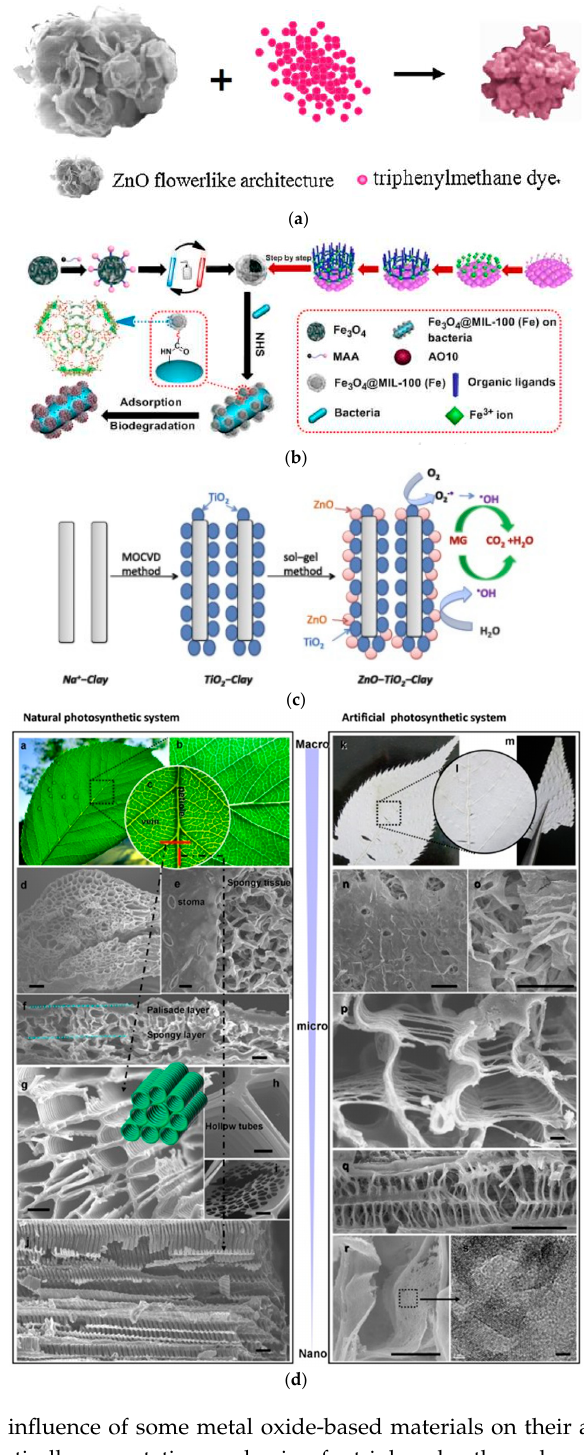
Figure 1. Structural influence of some metal oxide-based materials on their associated properties. ( a ) Absorption schematically presentation mechanism for triphenylmethane dyes on the ZnO flowerlike architectures. ( b ) AO 10 biodegradation and adsorption using Fe 3 O 4 MIL-100 (Fe) Core–Shell Bionanocomposites. ( c ) Design and application of ZnO–TiO 2 / clay. ( d ) Comparison of NPS (Cherry Blossom leaf) and APS (leaf-architectured SrTiO 3 ) morphology at macro-, micro- and